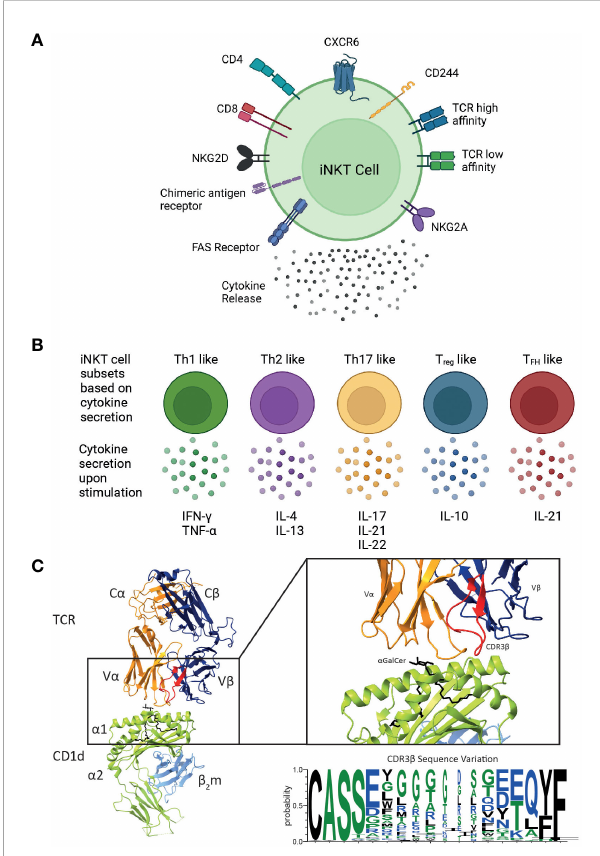
FIGURE 2 Overview of the different functional human iNKT cell subsets. CD1d- restricted human iNKT cells can be divided into distinct subsets based on their (A) cell surface receptor expression, T cell receptor (TCR) repertoire and cytokine pro fi le. Human iNKT cells can express the glycoproteins CD4 and CD8, but the majority of human iNKT cells are either CD4 + or CD4 - CD8 - (double negative), leading to four distinct subsets. They also express a variety of chemokine receptors and other cell surface molecules including NK receptors. Additionally, chimeric antigen receptors can be engineered on iNKT cells to target them to speci fi c malignancies. Expression of various surface molecules has been found to confer enhanced cytotoxicity. (B) Upon activation, iNKT cells secrete a unique pattern of cytokines, indicated for each subtype. (C) iNKT cells are de fi ned by the expression of their invariant TCR ab , however variation within the CDR3 b sequence (as shown in the sequence logo) confers differences in the af fi nity of the iNKT cell TCR CD1d-lipid interaction. These differences in phenotype, TCR af fi nity and cytokine pro fi le are all likely to impact their cytotoxic responses in vivo . Cartoons created with BioRender.com. Molecular graphics and analyses performed with UCSF ChimeraX; PDB code 4EN3. Sequence logo generated using WebLogo 3 using the CDR3 b sequences (97, 105,